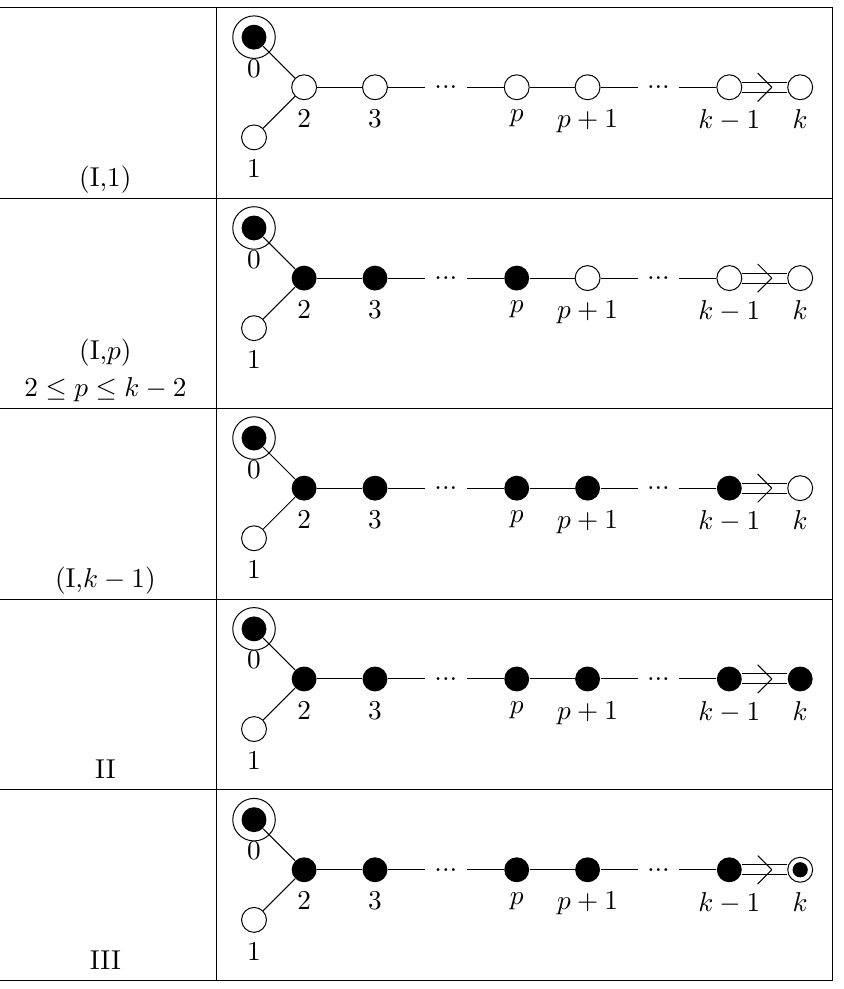
Table 2 . Root system types for so (2 ; 2 k (cid:0) 1) (for k (cid:21) 3). The circled node 0 is the maximal non-compact root (cid:12) , equal to the a(cid:14)ne root. The non-circled black nodes are the roots that are orthogonal to (cid:3). Because of the constraints on (cid:3), the root 1 can never be orthogonal to (cid:3). The small black dot means that the root satis(cid:12)es h (cid:3) ; (cid:11) i = 1 . The root system Q ((cid:3)) is the one generated 2 by the big black dots, and the root system R ((cid:3)) is the one generated by all the black dots.